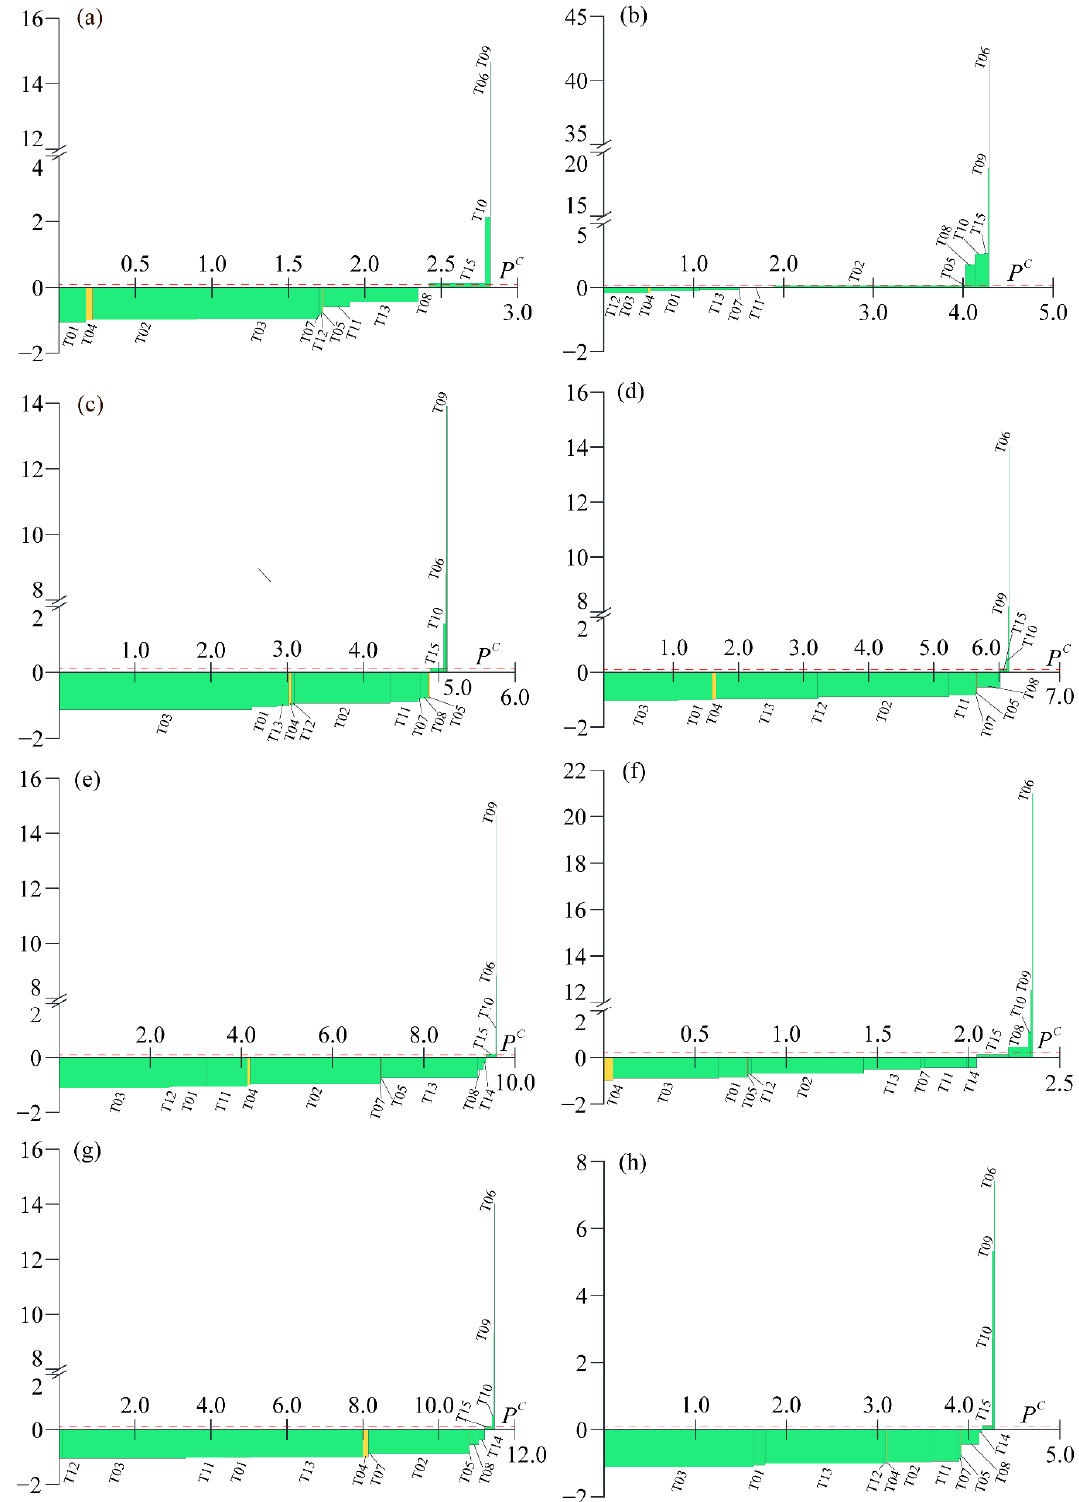
Figure 5. Carbon abatement cost curve for the underground iron mines by either caving (( a ) Xiaowanggou, ( b ) Yanqianshan, ( c ) Maogong, and ( d ) Shilu)), or backfilling method (( e ) Luohe, ( f ) Wuji, ( g ) Lilou, and ( h ) Longtangyan)). The vertical axis is the unit cost for mitigating carbon emissions, in k CNY/t CO 2 eq, and the horizontal axis is the cumulative carbon abatement potential in kt CO 2 eq/a. The dotted line in red represents the break-even price of carbon emissions (PC), which equals to 100 CNY/t CO 2 eq. The colors indicate the type of carbon source that the ECCA technology targets to save, e.g., green and yellow represent electricity and fossil fuel,